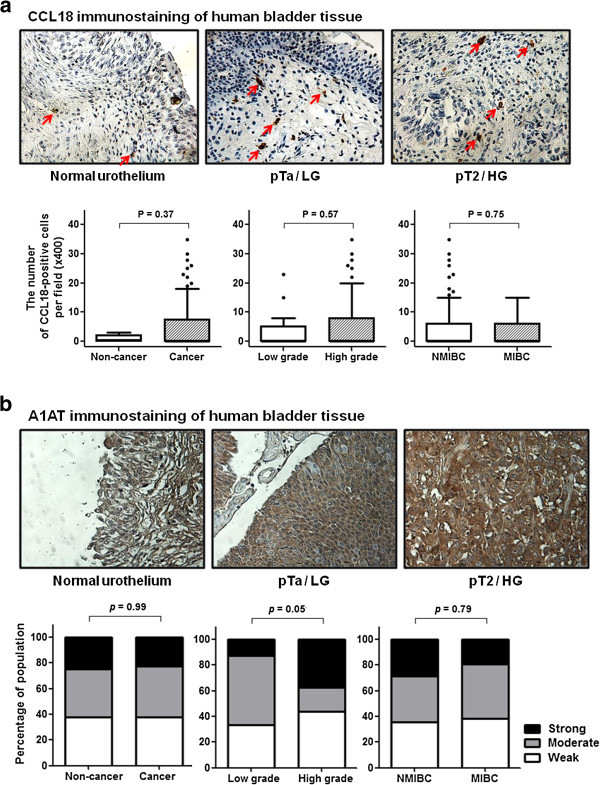
Assessment of CCL18 and A1AT in bladder tissue. a) Representative immunostaining of benign bladder for CCL18 (top-left), low-grade non-muscle invasive bladder cancer for CCL18 (top-middle), and high-grade muscle invasive bladder cancer for CCL18 (top-right). Red arrows indicate CCL18-positive cells in the stroma. CCL18 staining was present only in inflammatory cells associated with the stroma. Lower panels are boxplots of CCL18 immunohistochemical staining intensity of benign bladder vs. bladder cancer, low-grade vs. high-grade, non-muscle invasive bladder cancer (NMIBC) vs. muscle invasive bladder cancer (MIBC). Error bars indicate standard deviations. Wilcoxon rank sum test was used to assess significance. b) Representative immunostaining of benign bladder for A1AT (top-left), low-grade non-muscle invasive BCa for A1AT (top-middle), and high-grade muscle invasive BCa for A1AT (top-right). A1AT staining was present in the cytoplasm and stroma. A1AT staining varied from weak and focal to strong and diffuse. Lower panel shows column bar graphs of A1AT immunohistochemical staining intensity of benign bladder vs. bladder cancer, low-grade vs. high-grade, NMIBC vs. MIBC.